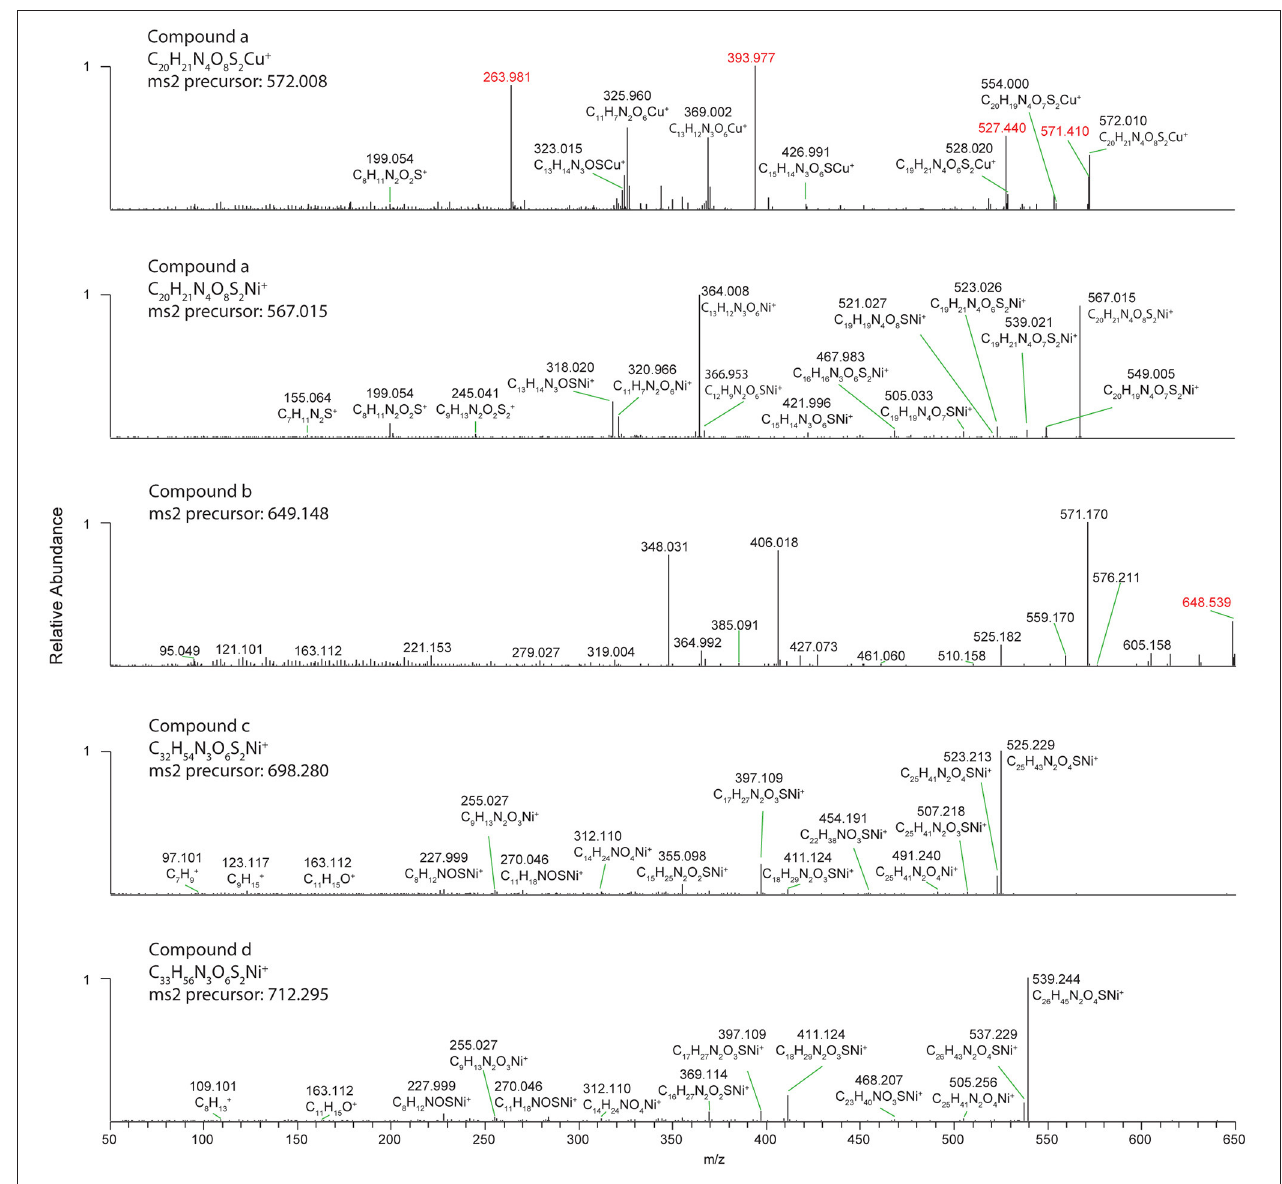
FIGURE 5 | High resolution MS 2 fragmentation spectra of Cu and Ni compounds detected in oligotrophic Eastern Tropical South Pacific. The first and second panels show spectra for the 63 Cu and 58 Ni isotopologues of the same ligand (compound a ). The bottom three panels show spectra for the 58 Ni isotopologues of compounds ( b–d ). Red masses are likely fragments from interfering isobaric